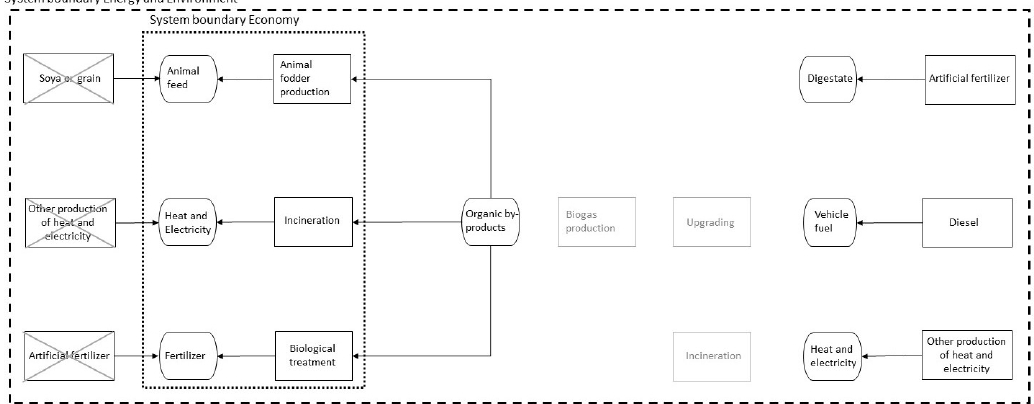
Figure 2. Scenario BAU. The collected by-products are used for either incineration or animal fodder production or are treated biologically. The dotted line shows the system boundary for the economic perspective and the crosshatched line shows the system boundary for the energy and environmental perspectives. The boxes in grey are not included in the scenario and the crossed boxes are the alternative treatment methods